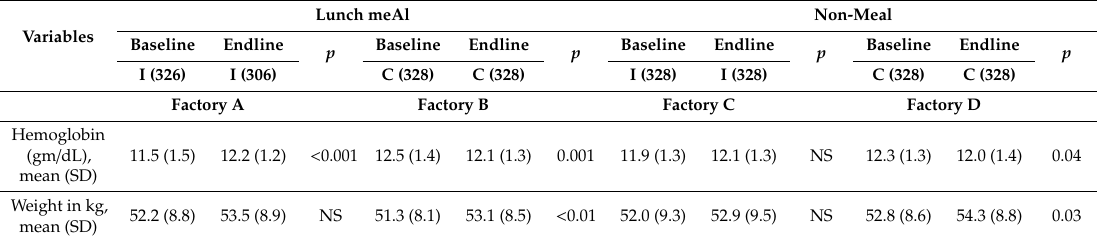
Table 5. Changes in hemoglobin (gm / dL) and weight (kg) over